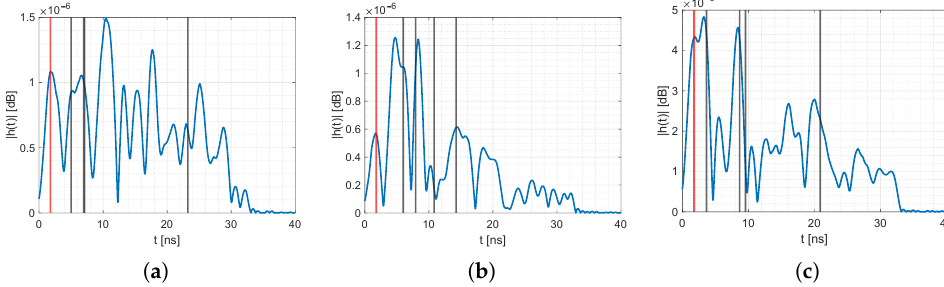
Figure 12. Idle CIRs for different sensor pairs. ( a ) CIR with MPCs from (2,3). ( b ) CIR with MPCs from (2,4). ( c ) CIR with MPCs from